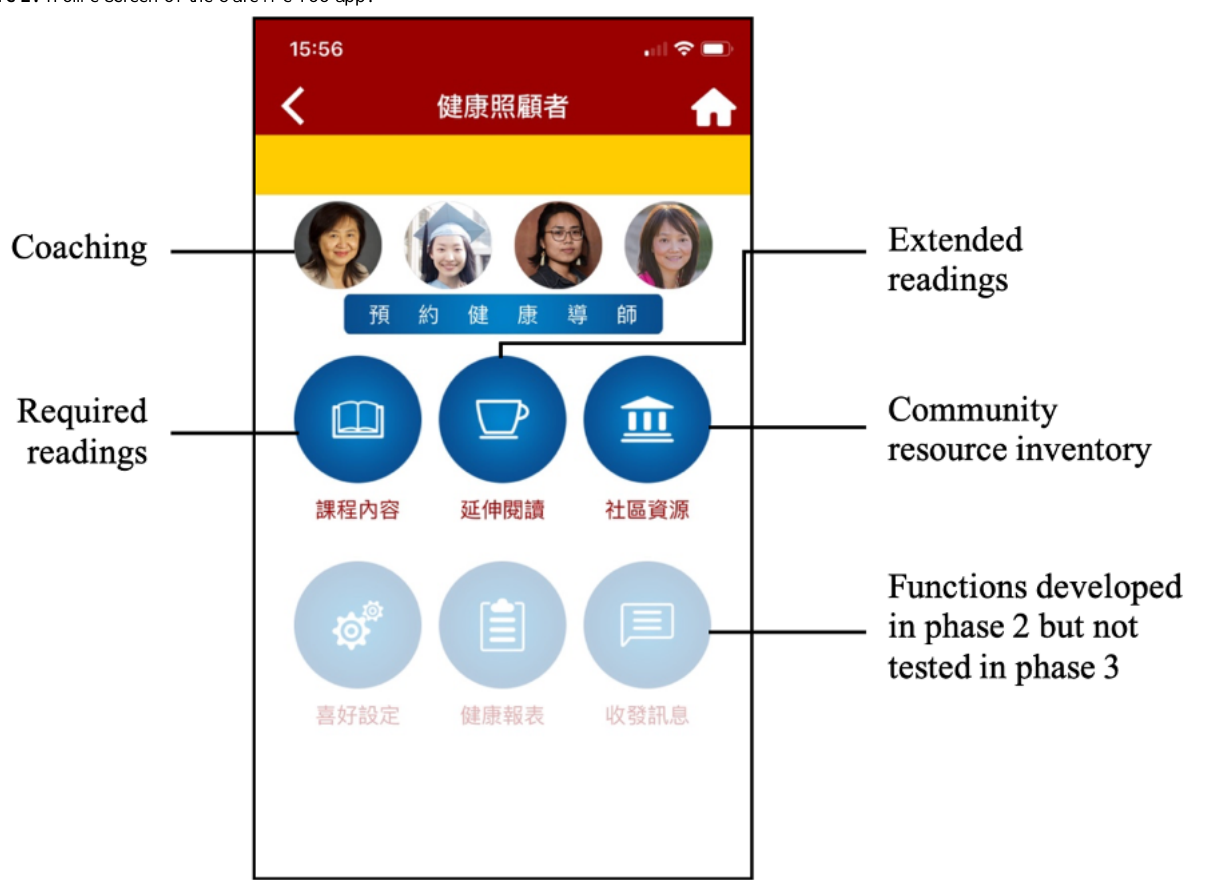
Figure 2. Home screen of the Care Me Too